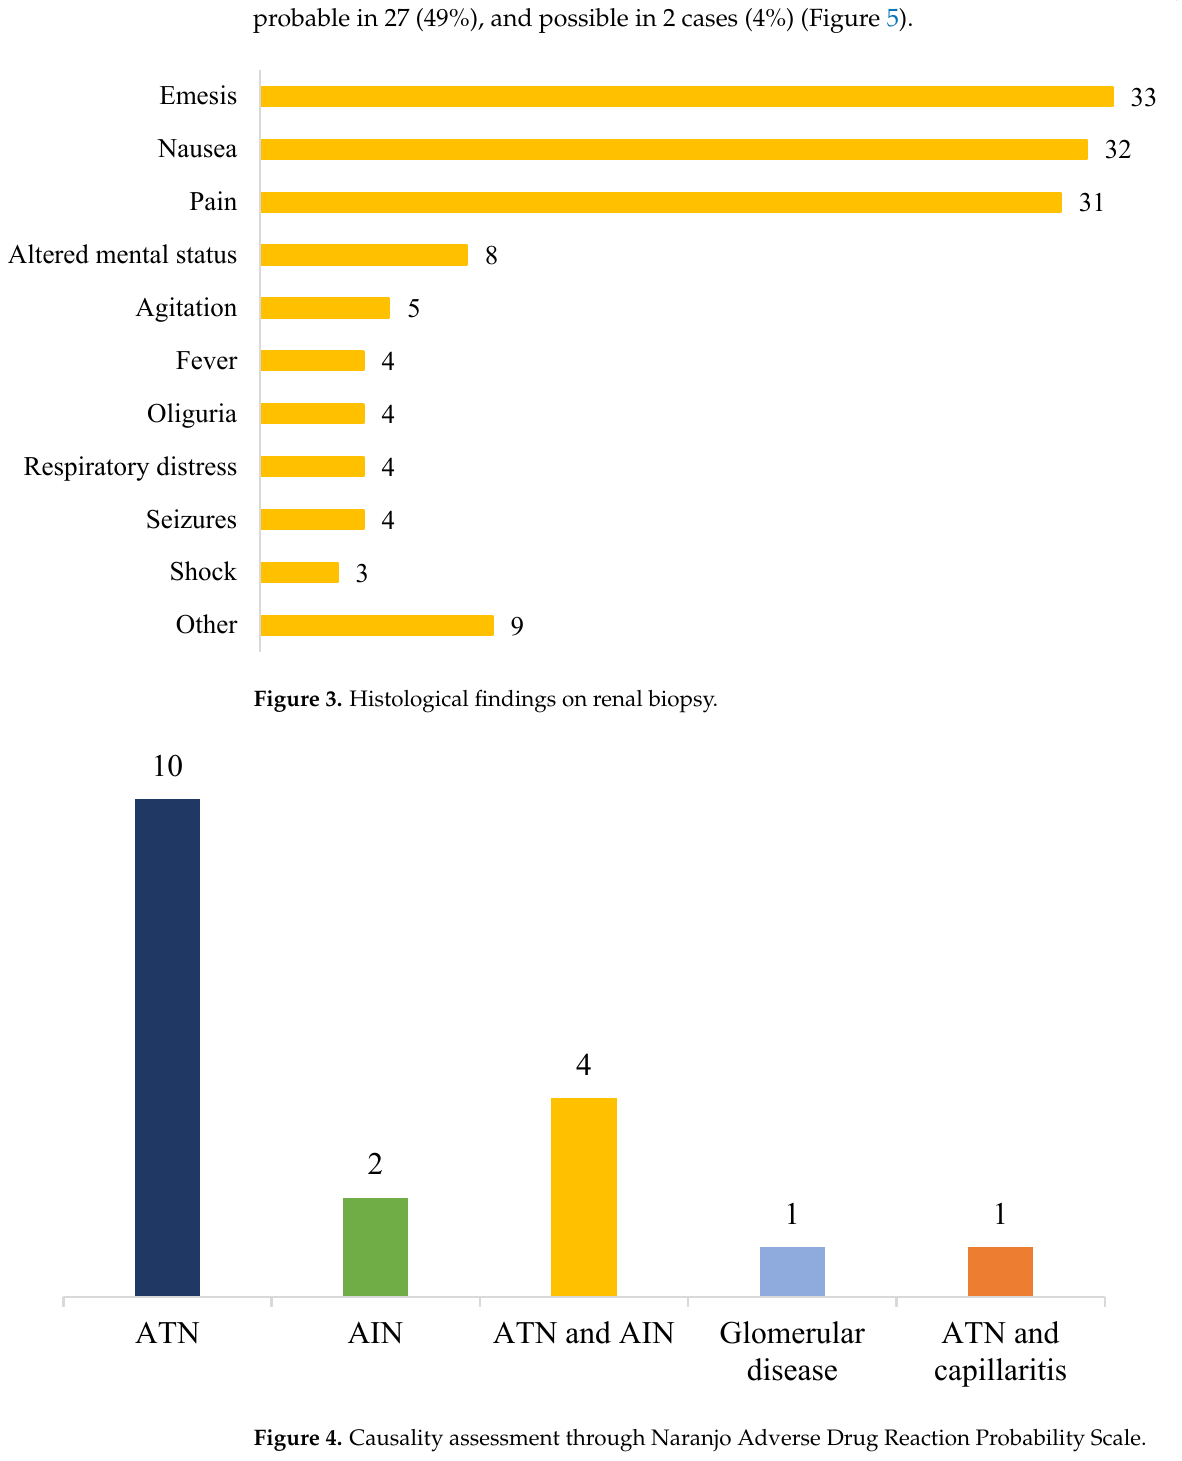
Figure 4. Causality assessment through Naranjo Adverse Drug Reaction Probability Figure 4. Histological findings on renal biopsy.